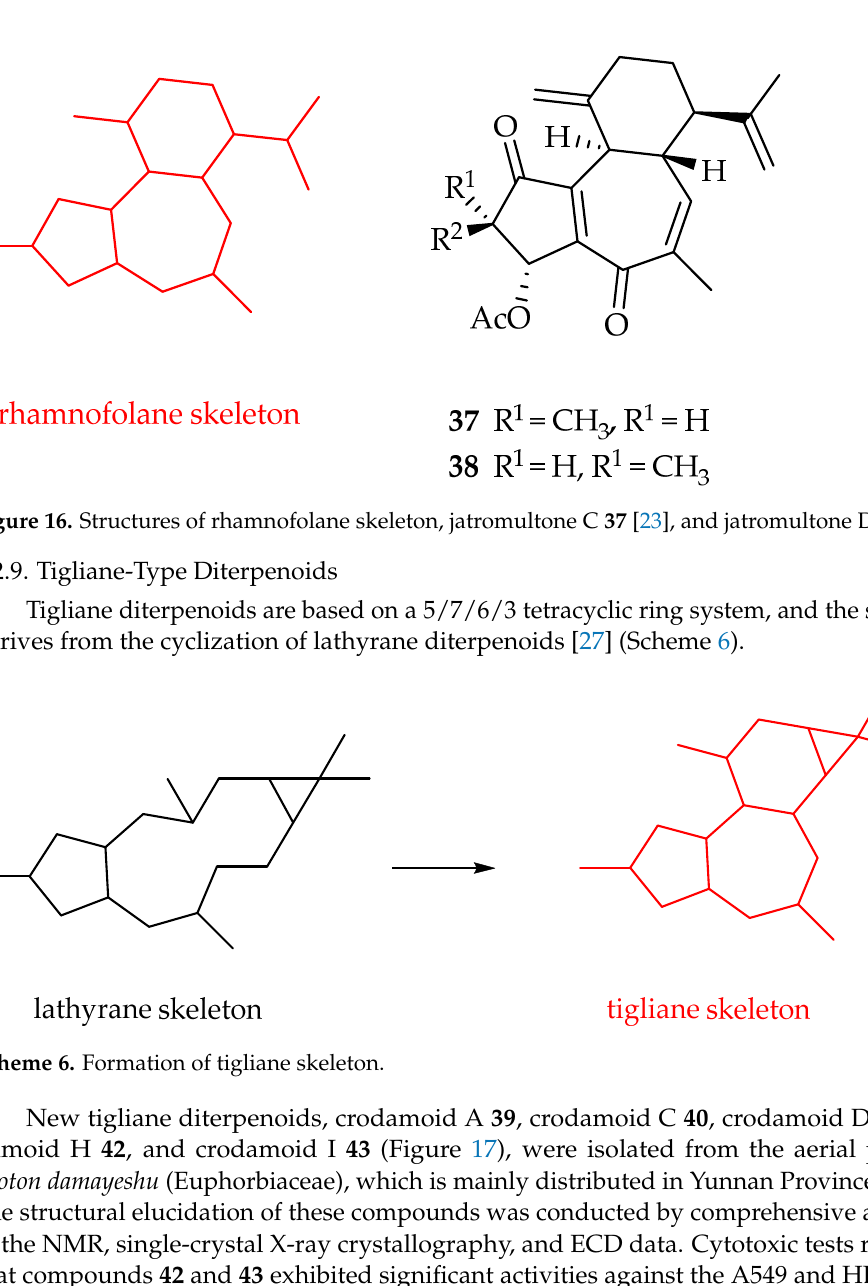
Figure 17. Structures of crodamoid A 39 , crodamoid C 40 , crodamoid D 41 , crodamoid H 42 , and crodamoid I 43 [28]. Crotonol A 44 and crotonol B 45 were isolated from the leaves of Croton tiglium (Eu- phorbiaceae), and crotonol B 45 represents the first example of a 13,14- seco -tigliane diterpenoid (Figure 18). Crotonols A 44 and B 45 were evaluated in vitro for their cytotox- icity against the K562, MCF-7, and SGC-7901 (human gastric cancer) cell lines, with paclitaxel as a positive control. Compounds 44 and 45 showed strong cytotoxic activities (IC 50 0.20 and 0.21 μM, respectively), better than paclitaxel, towards the K562 cell line, while exhibiting low cytotoxicity in the MCF-7 and SGC-7901 cancer cell lines [29].